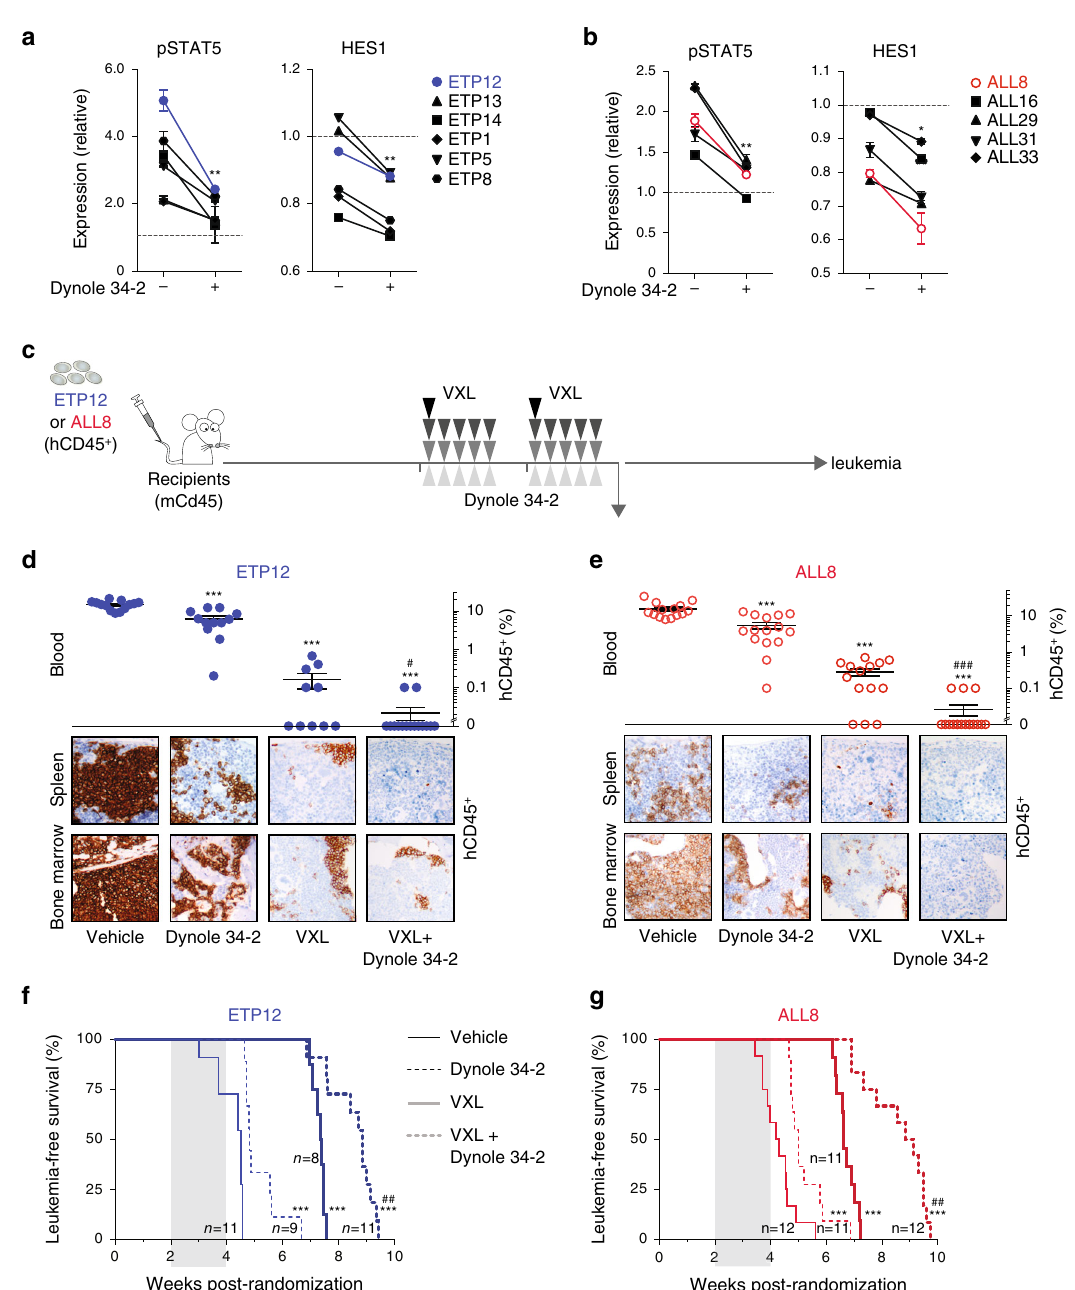
Fig. 6 Dynole 34-2 is effective against human ETP-ALL and mature T-ALL. a , b Relative levels of IL-7-induced activation of STAT5 (pStat5, left) and NOTCH1-induced expression of HES1 (right) in ( a ) ETP-ALL and ( b ) T-ALL cells from human xenografts treated with vehicle and Dynole 34-2, after in vitro stimulation. ETP12 is depicted with solid blue circles, ALL8 with red open circles and all other leukemias in black. Levels in unstimulated xenograft cells treated with vehicle were used as control, and reported as 1 (dashed line). Mean ± SD ( N = 6 primary leukemias, performed in duplicate), two-way ANOVA with Bonferroni correction test; * P < 0.05 and ** P < 0.01 as compared to vehicle. c Experimental setting for testing the ef fi cacy of Dynole 34-2, VXL and combination therapy in xenograft models of human acute leukemia. Sublethally irradiated NSG recipients were randomized after engraftment was con fi rmed in the peripheral blood, and subsequently treated when the average proportion of human leukemic cells in the peripheral blood reached 1%. d , e Proportion of patient-derived cells (%hCD45 + ) in the peripheral blood (top), as well as immunochemistry against hCD45 + leukemic cells in the bone marrow and spleen (bottom) of recipients injected with ETP12 ( d ) and ALL8 ( e ), 24 h after th e last drug injection. Scale bars: 10 μ m. Mean± SEM, two-way ANOVA with Tukey ’ s correction test; *** P < 0.0001 compared to vehicle; # P < 0.05 and ### P < 0.0001 compared to VXL. Each circle represents an individual recipient. f , g Kaplan – Meier curves of sublethally irradiated recipients injected with ETP12 ( f ) and ALL8 ( g ), administered with either vehicle or Dynole 34-2, as a single agent or in combination with VXL chemotherapy. Log-rank (Mantel – Cox) test; *** P < 0.0001 compared to vehicle; ### P < 0.0001 compared to VXL. The period of administration is indicated in light grey, with the number of recipients for each cohort indicated for ETP12 and ALL8 xenograft